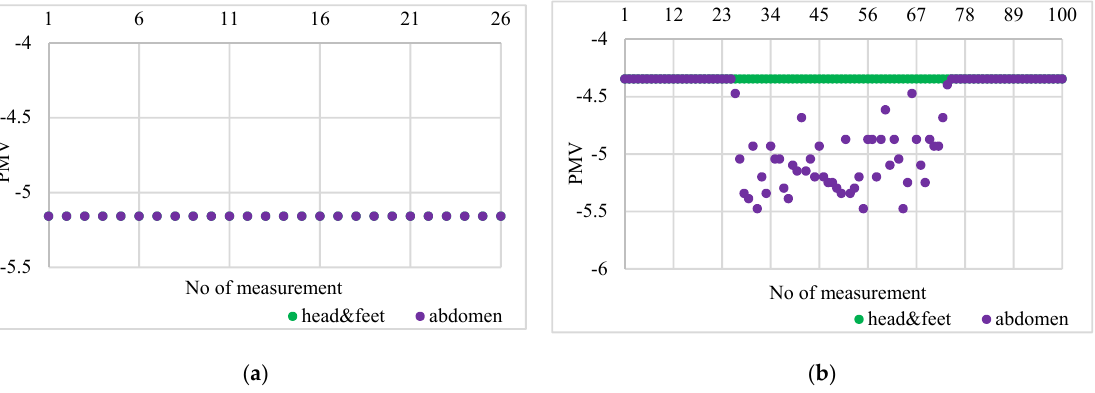
Figure 2. The course of the PMV index with the use of a device without heat recovery: ( a ) cycle 2 min, ( b ) cycle 10 min [29].